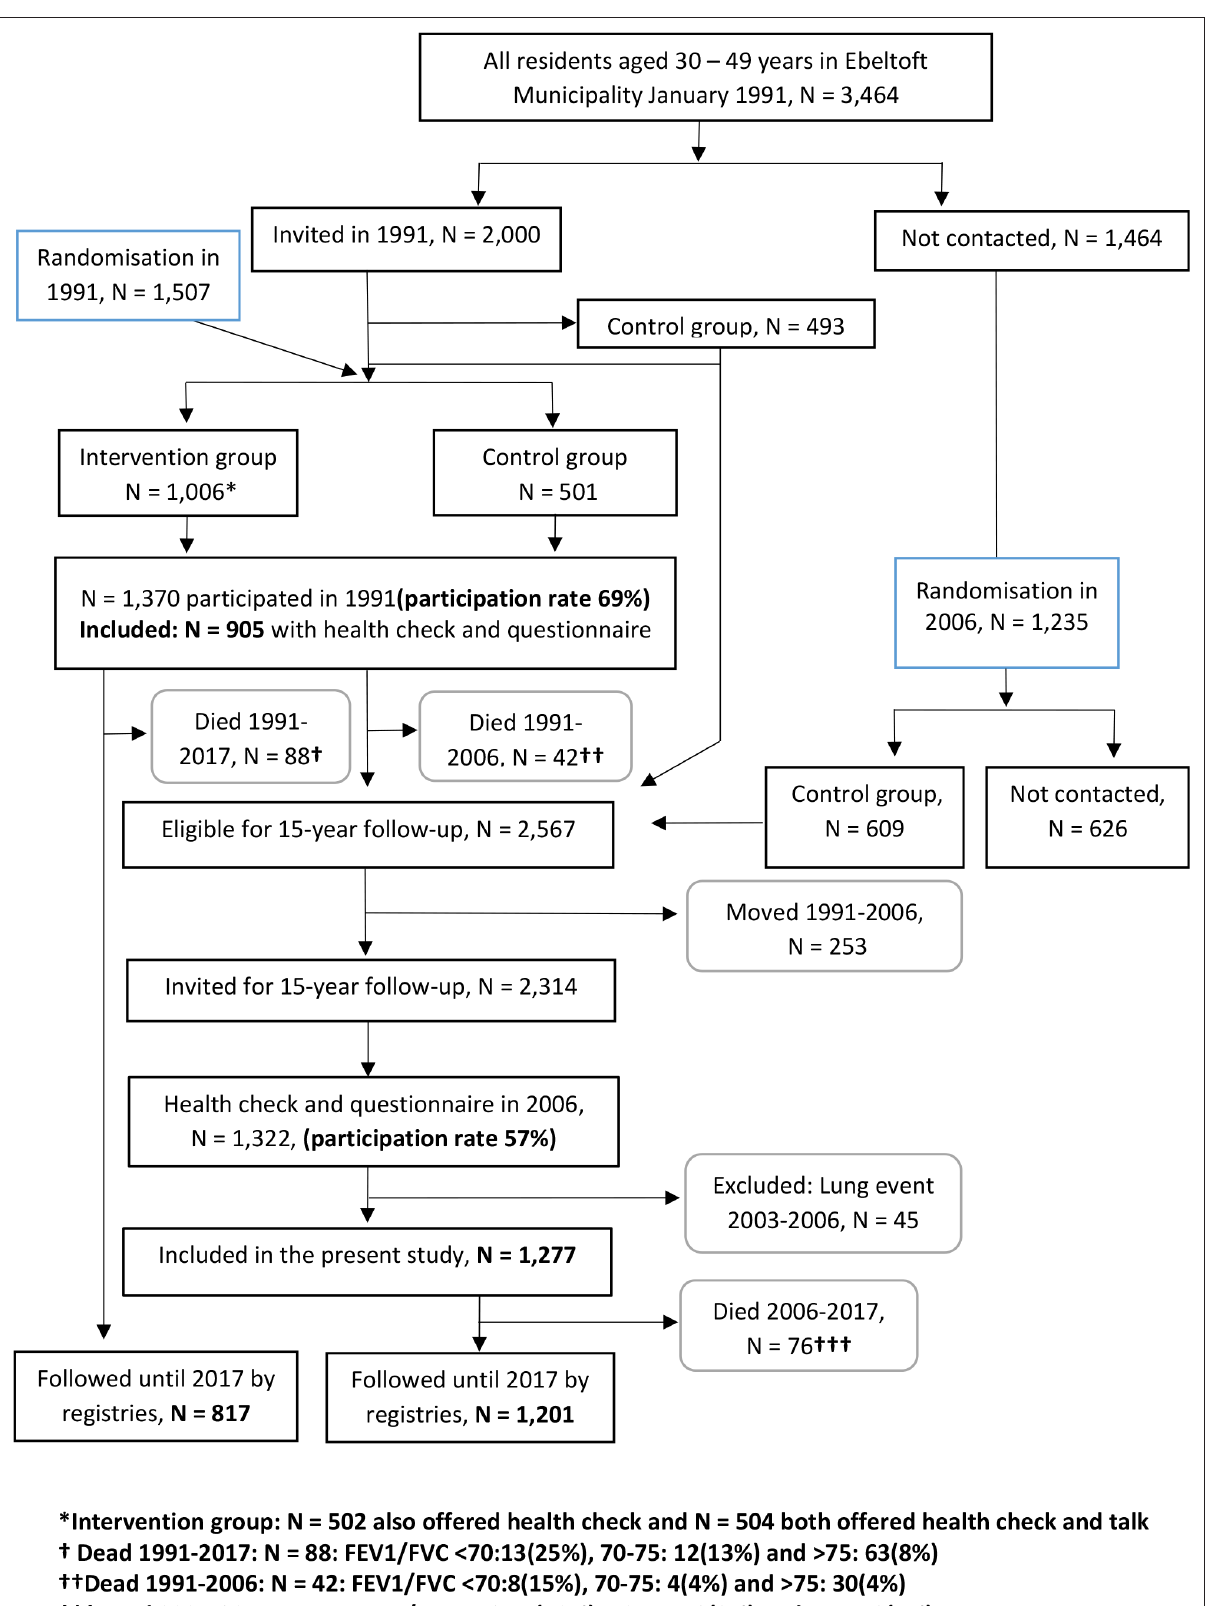
Figure 1 Flowchart of participant